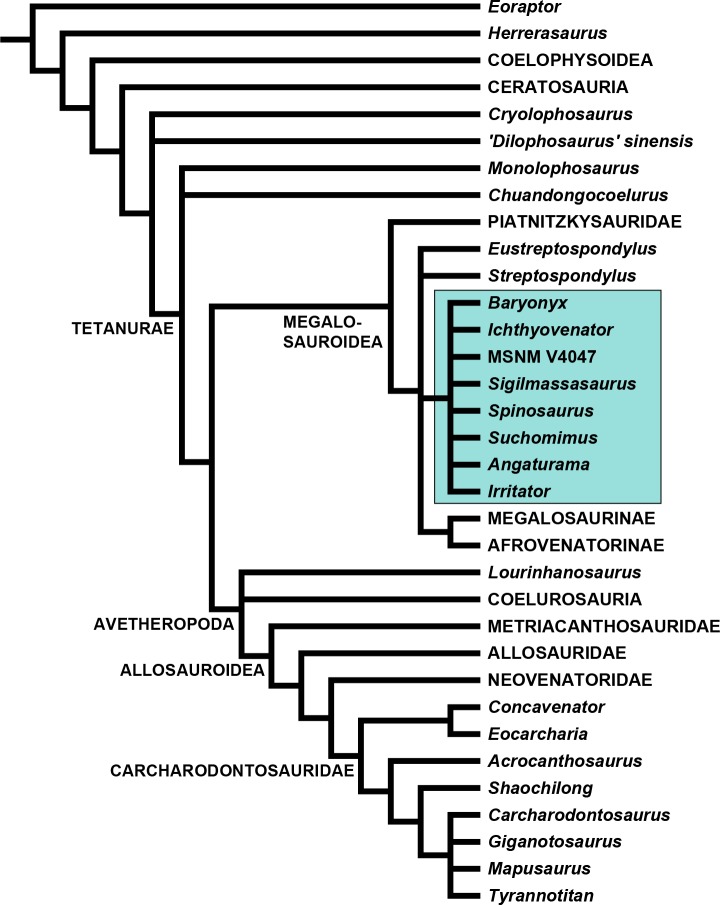
Reduced consensus tree from our phylogenetic analysis after pruning Xuanhanosaurus using 3,070 most parsimonious trees.Capitalised terminal clades have been summarised, but are fully shown in a version of this tree in Fig. S6. Note that Sigilmassasaurus is found in a monophyletic Spinosauridae, highlighted by a turquoise box.